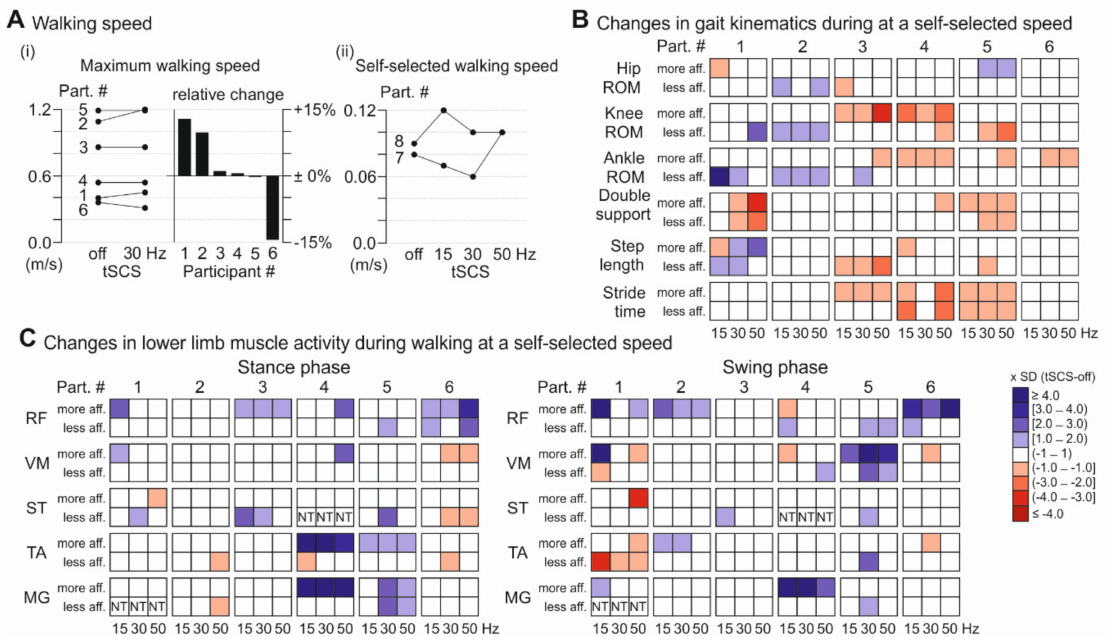
Figure 3. E ff ect of tSCS on over-ground walking performance. ( A ) Walking speed assessed on a 7 m track using the FLOAT-BWS system. ( i ) Absolute maximum walking speed of the six participants (see Section 2.2 Study protocol) completing the assessment during tSCS-o ff and 30-Hz tSCS, along with relative changes. ( ii ) Self-selected walking speed across tSCS conditions as indicated of the two participants (see Section 2.2 Study protocol) unable to maintain a constant speed over 7 m (both did not perform maximum walking speed assessment). ( B ) Changes in gait kinematics during 15-Hz, 30-Hz, and 50-Hz tSCS, given as multiples of the SD of the respective values in the tSCS-o ff condition (z-scores), and illustrated by the opacity of blue (indicating an increase) and red (decrease) boxes. Shown are data derived from the more and less a ff ected lower limbs of participants 1–6 who walked at a constant self-selected speed across tSCS conditions. ( C ) Changes in lower limb muscle activation (RMS values) during stance (left) and swing phases (right). MG values of the less a ff ected lower limb of participant 1, and ST values of the less a ff ected lower limb of participant 4 are missing data. BWS, body-weight support; FLOAT, free levitation for over-ground active training; MG, medial gastrocnemius; RF, rectus femoris; ST, semitendinosus; TA, tibialis anterior; VM, vastus